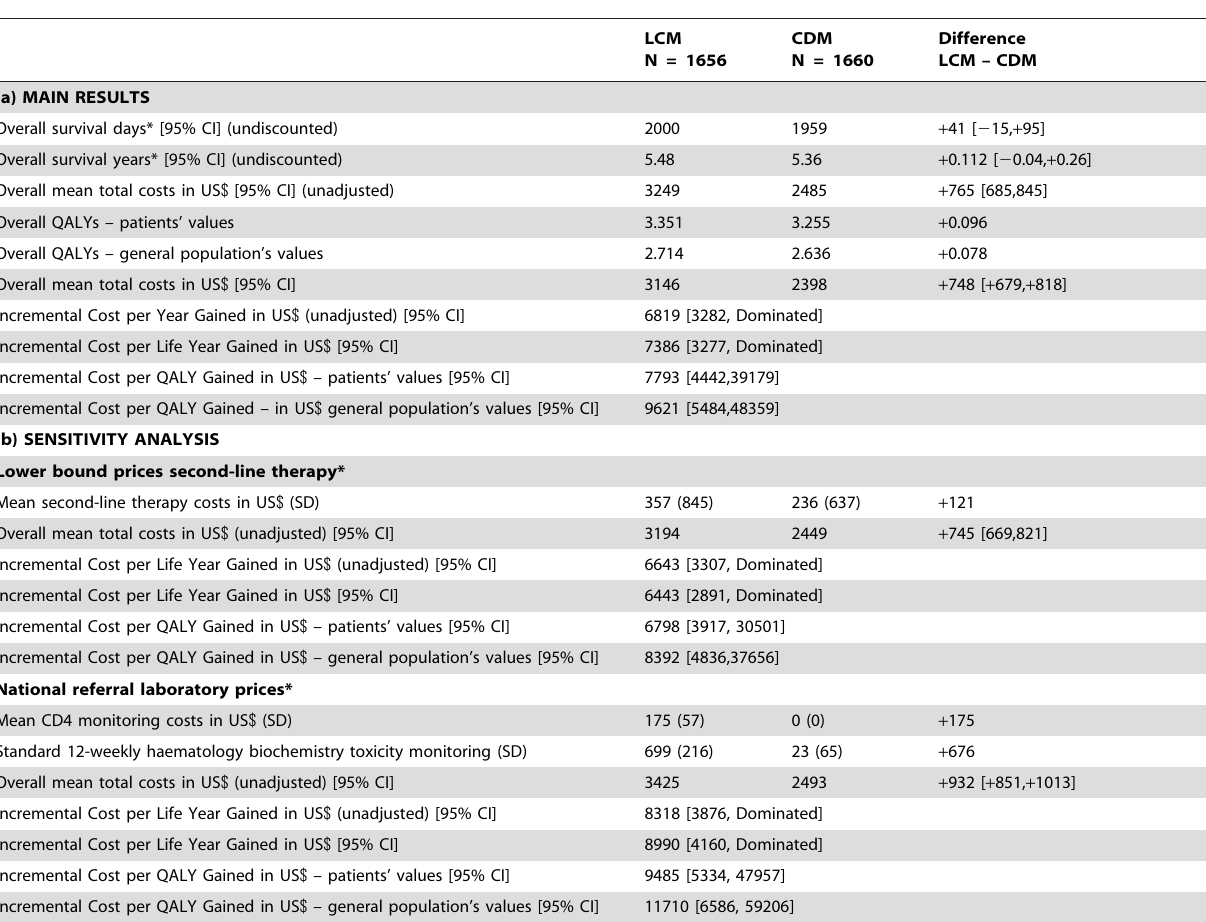
Table 3. Main and sensitivity analyses: life years gained, QALYs, costs and